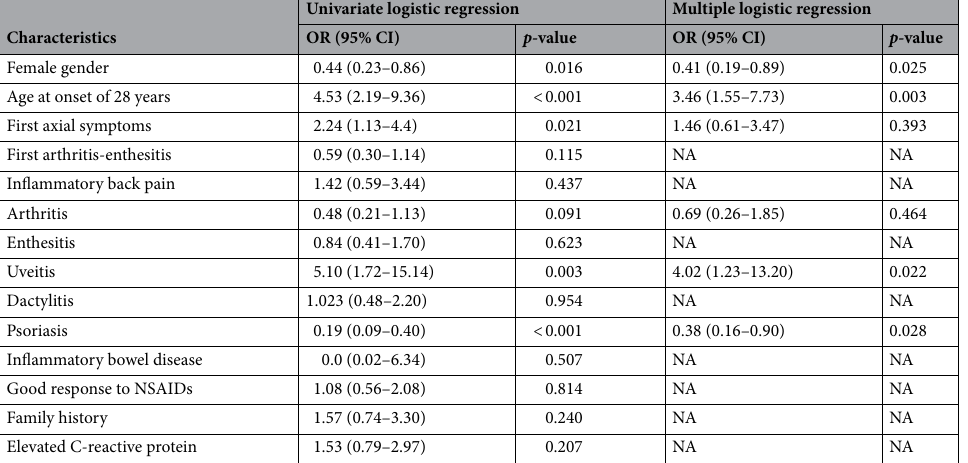
Table 2. Clinical characteristics associated with HLA-B27 among 177 patients with axial spondyloarthritis. Age at onset of 28 years age at onset of the first musculoskeletal symptoms of ≤ 28 years, Family history presence in first-degree or second-degree relatives of any of the following: ankylosing spondylitis, psoriasis, uveitis, reactive arthritis, or inflammatory bowel disease, First axial symptom first presentation with inflammatory back pain and/or buttock pain, First arthritis-enthesitis, first presentation with peripheral arthritis or enthesitis, NA not applicable, NSAIDs non-steroidal anti-inflammatory drug. A p -value < 0.05 indicates statistical significance; logistic regression analysis was used to identify significantly associated factors with HLA-B27 among axial spondyloarthritis; the dependent factor was axial spondyloarthritis with positive